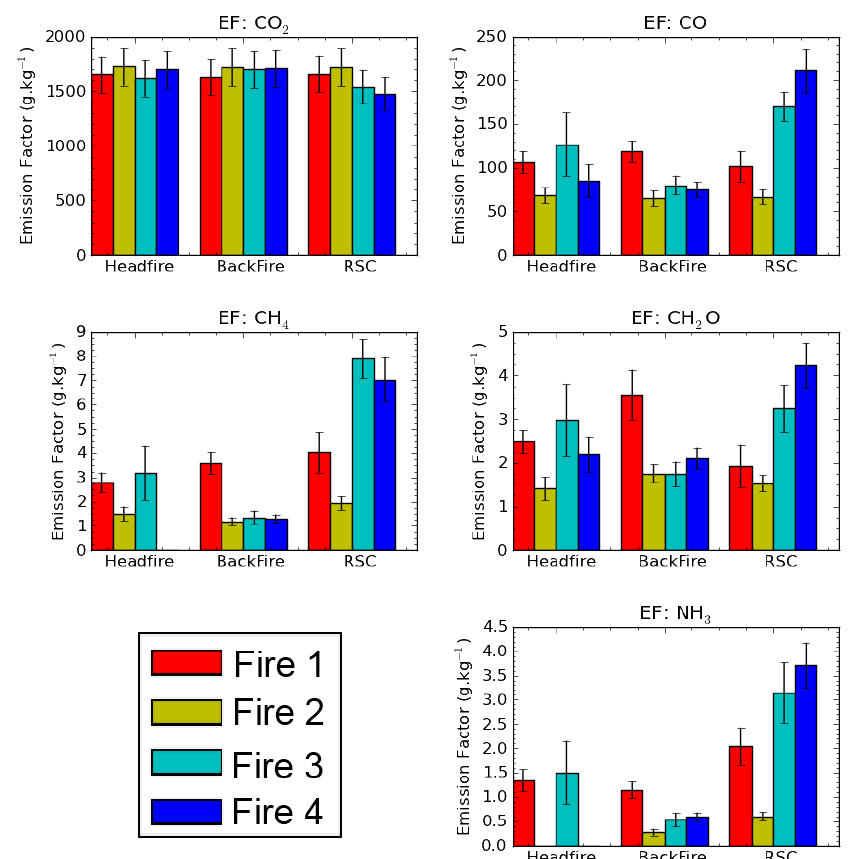
Fig. 9. Emissions factors [EF x ] for CO 2 , CO, CH 2 O and NH 3 for the backfire, headfire and residual smouldering combustion stages (RSC) of Fires 1, 2, 3 and 4 (see Table 1 for fire details). Error bars provide a measure of emissions factor uncertainty, derived in quadrature from the uncertainty in the relevant emission ratios and a ± 10% uncertainty in the assumed fuel C content. Missing values represent cases where the relevant ER x/CO2 measure was poorly constrained, based on a low coefficient of determination (r²) between the two relevant trace gas column amounts (see Figure 8).